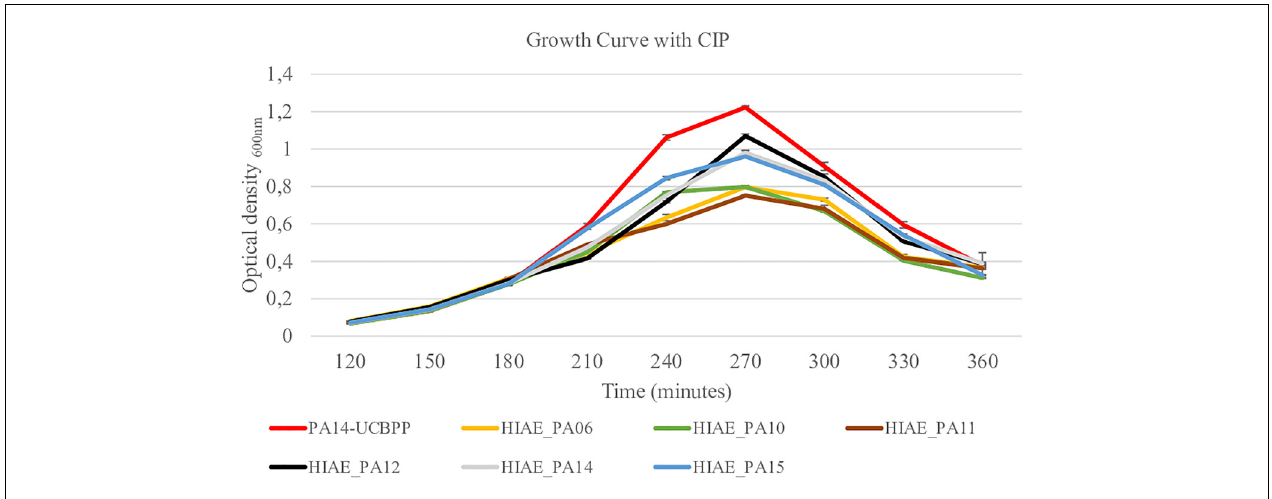
FIGURE 3 | Growth curves for reference strain PA14-UCBPP and clinical isolates following treatment with sub-inhibitory concentrations of CIP. Sub-inhibitory concentrations of CIP were 0.03 µ g/mL for HIAE_PA11 and 0.06 µ g/mL for the other strains and CIP was added when OD 600 reached 0.25 (at 180 min). N = 10. TABLE 2 | Growth rates for the clinical strains and PA14-UCBPP reference strain in exponential phase in the presence and absence of CIP. PA14-UCBPP